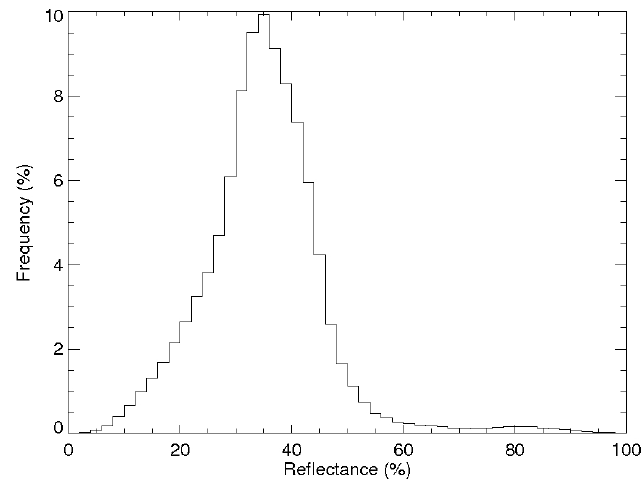
Figure 3. Probability density distribution of 0.67 μ m reflectance for the ice covered pixels shown in Figure 2.